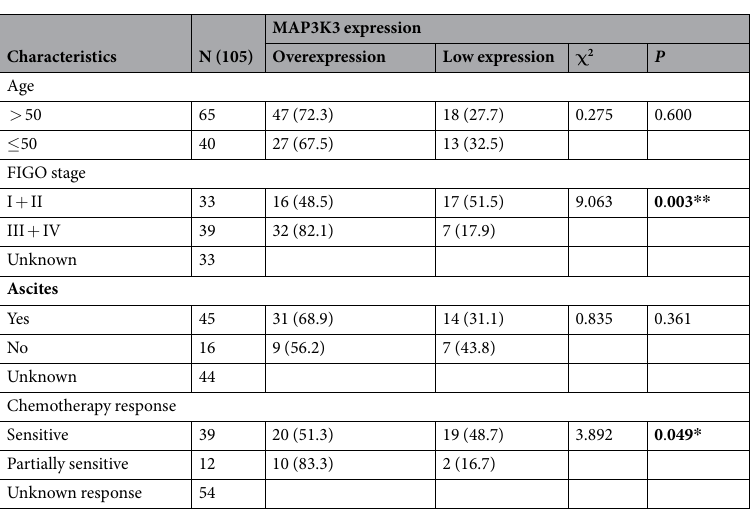
Table 2. Correlation of MAP3K3 Expression with Clinicopathological Parameters in HGSOC Patients. Abbreviations: HGSOC, High-Grade serous ovarian